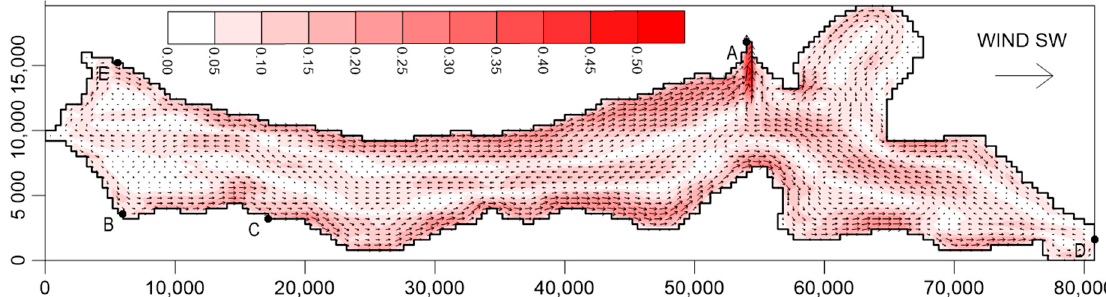
Figure 12. Water flow velocity (m s − 1 ) after 12 h of a SW wind at a speed of 12 m s − 1 and without the Figure 12. Water flow velocity (m s -1 ) after 12 hours of a SW wind at a speed of 12 m s -1 and without Water 2019 , 11 , 990 new artificial strait at point E (dimensions in meters). the new artificial strait at point E (dimensions in meters). Figure 12. Water flow velocity (m s -1 ) after 12 hours of a SW wind at a speed of 12 m s -1 and without the new artificial strait at point E (dimensions in meters). Figure 12. Water flow velocity (m s -1 ) after 12 hours of a SW wind at a speed of 12 m s -1 and without the new artificial strait at point E (dimensions in meters).